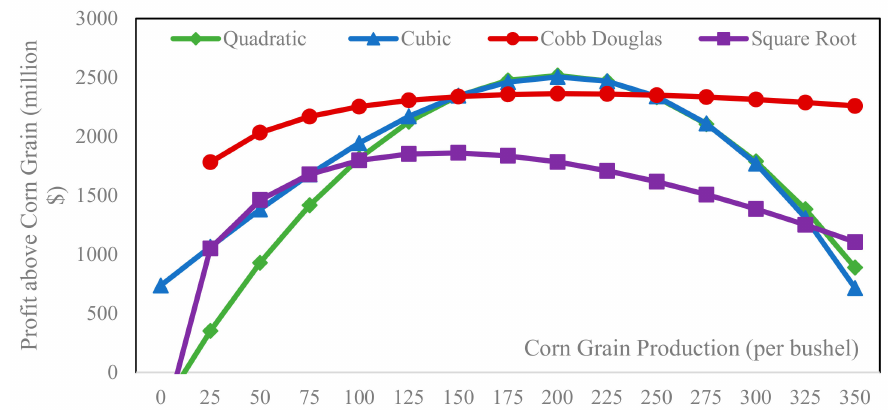
Figure 3. Estimated Profit above Corn Grain, All